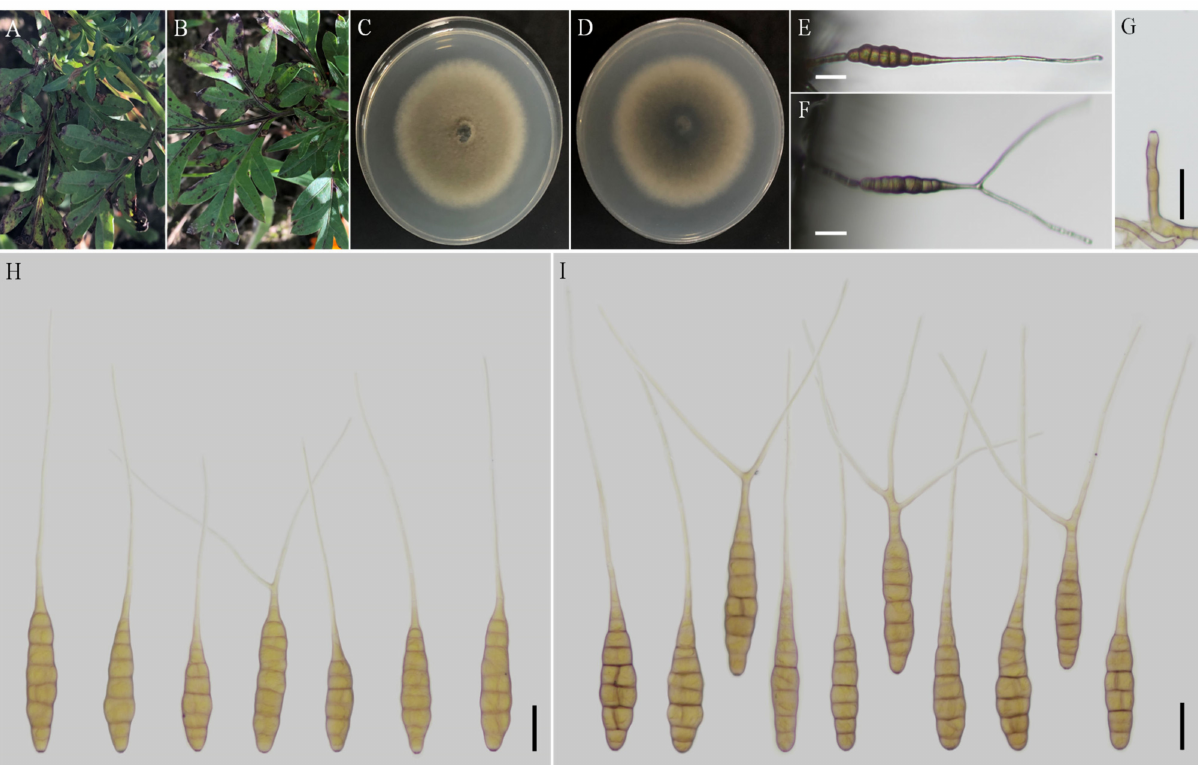
Figure 6. Morphology of Alternaria sulphureus sp. nov. ( A , B ) Natural symptoms of Cosmos sulphureus ; ( C , D ) Colony phenotypes (on PDA for 7 days at 25 ◦ C); ( E , F ) Sporulation patterns (on PCA at 22 ◦ C); ( G ) Conidiophores (on PCA at 22 ◦ C); ( H ) Conidia (on V8A at 22 ◦ C); ( I ) Conidia (on PCA at 22 ◦ C). Bars: ( E – I ) = 25 µ